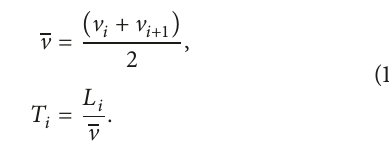
Figure 9: Virtual node diagram.